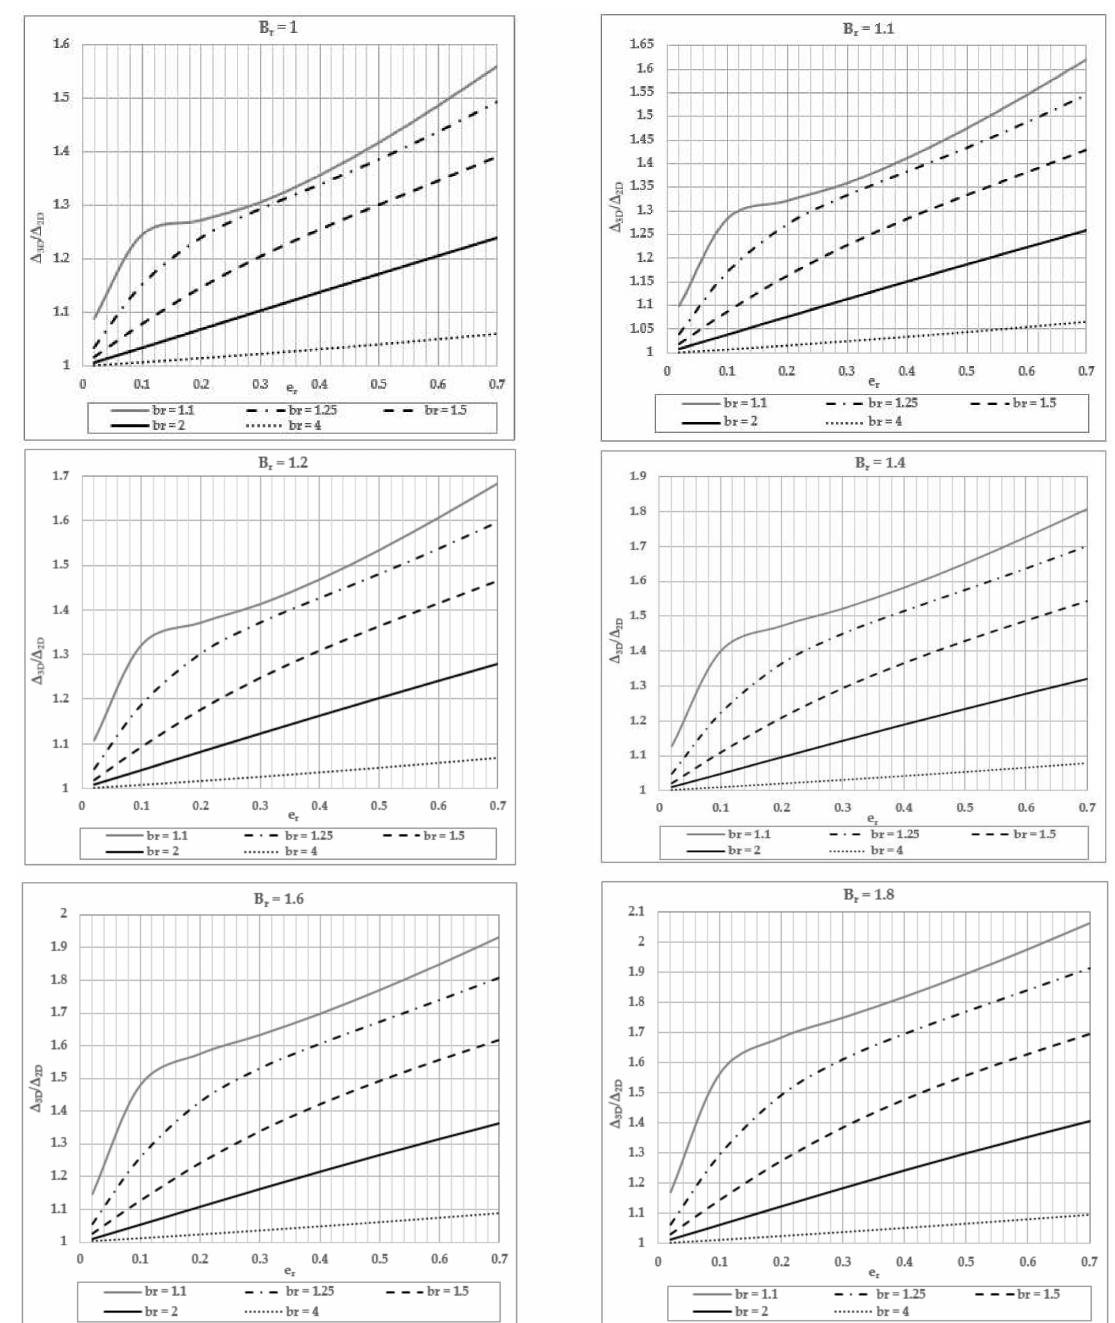
Figure 9. Edge 3D to 2D displacement ratio for velocity-controlled condition ( T 1 < T n 1 ≤ T 2